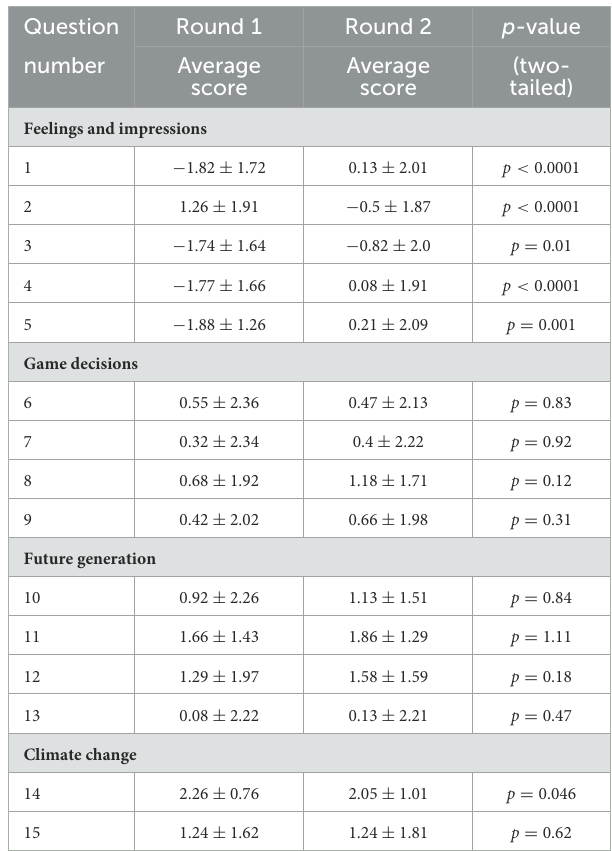
TABLE 1 Results of the